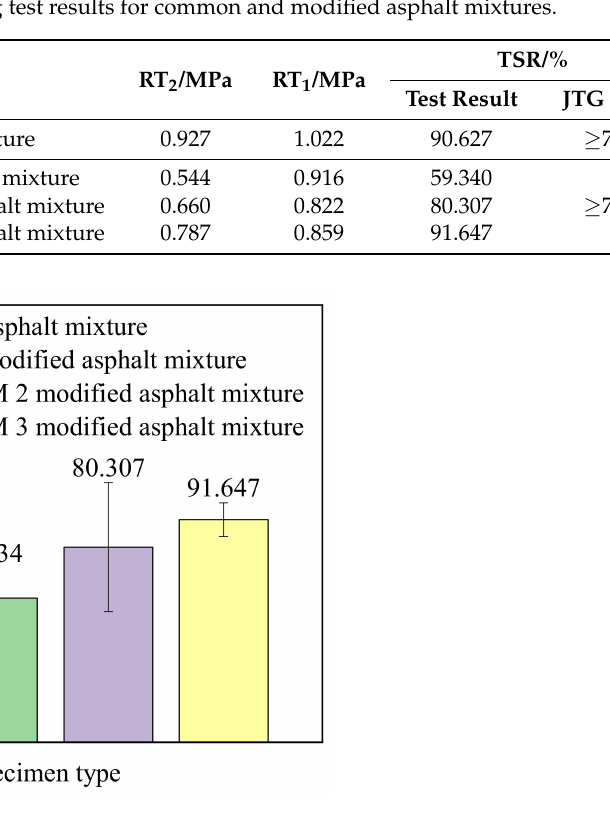
Figure 6. TSR results for common and modified asphalt mixtures in the performed freeze–thaw splitting